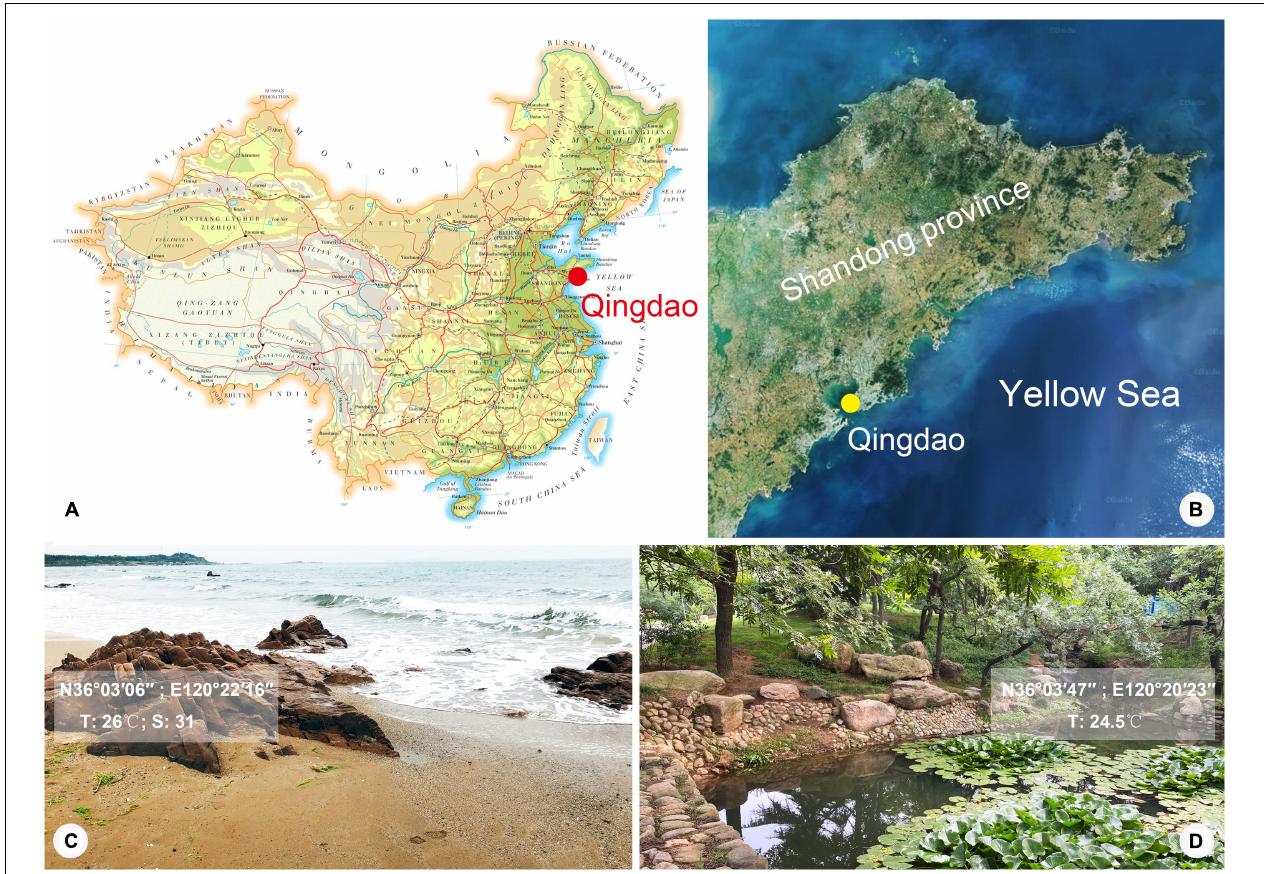
FIGURE 1 | Map and satellite image showing location of Qingdao and photographs showing sampling sites. (A) Map of China, showing location of Qingdao. (B) Satellite image of Shandong Province, showing location of Qingdao. (C,D) Photographs of sampling sites in Qingdao where Foissnerophrys alveolata gen. n., sp. n. (C) and Lagynus binucleatus sp. n. (D) were